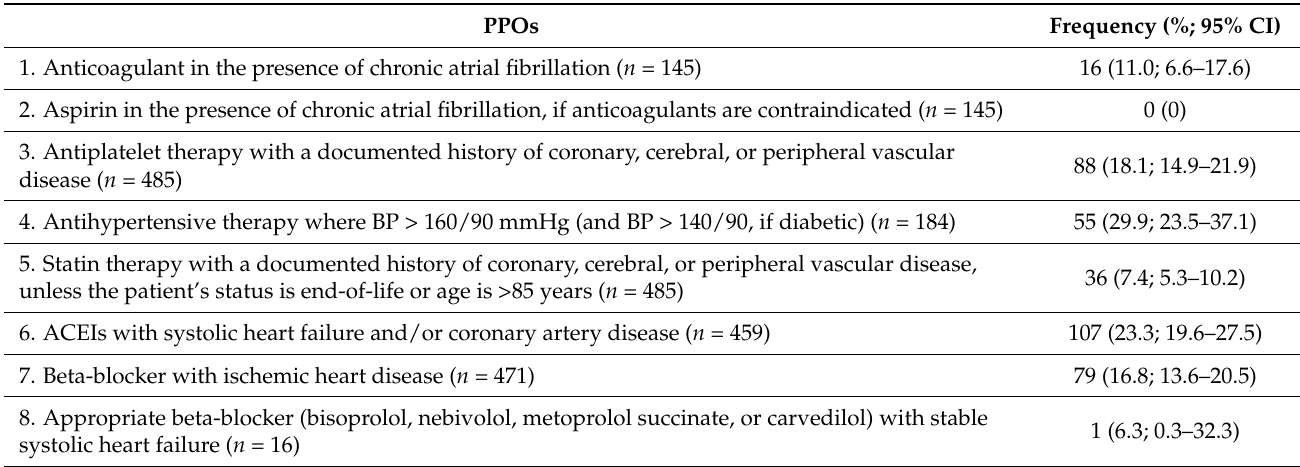
Table 4. Potentially prescribing omissions (PPOs) based on START criteria among